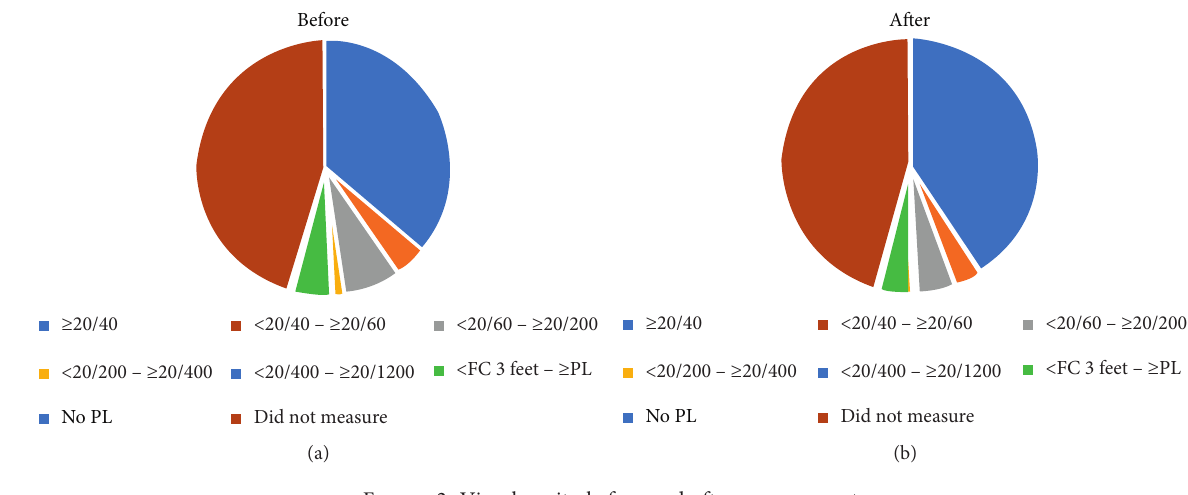
Figure 2: Visual acuity before and after management.